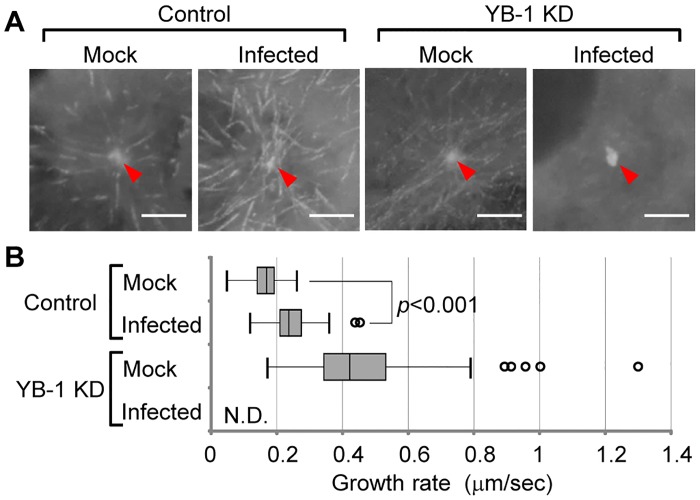
Microtubule nucleation from the centrosome visualized by EB1-GFP.(A) Live-cell imaging of EB1-GFP nucleated from the centrosome. After 48 h post treatment of either non-targeting or YB-1 siRNA, HeLa-EB1-GFP cells were infected with influenza virus. At 8 h post infection (MOI = 10), the cells were subjected to the live-cell imaging using confocal microscopy. Images were acquired at 1.56-sec intervals for 1 min (see also S1, S2, S3 and S4 Videos). The stack examples of each time-lapse image are shown (panel A). Red arrowheads indicate the position of the centrosome. Scale bar, 5 μm. (B) The quantitative results of growth rate distribution of EB1-GFP particles (over 80 particles obtained from more than ten cells) were determined from three independent experiments. The level of significance was determined by Student’s t test. N.D., not detectable.